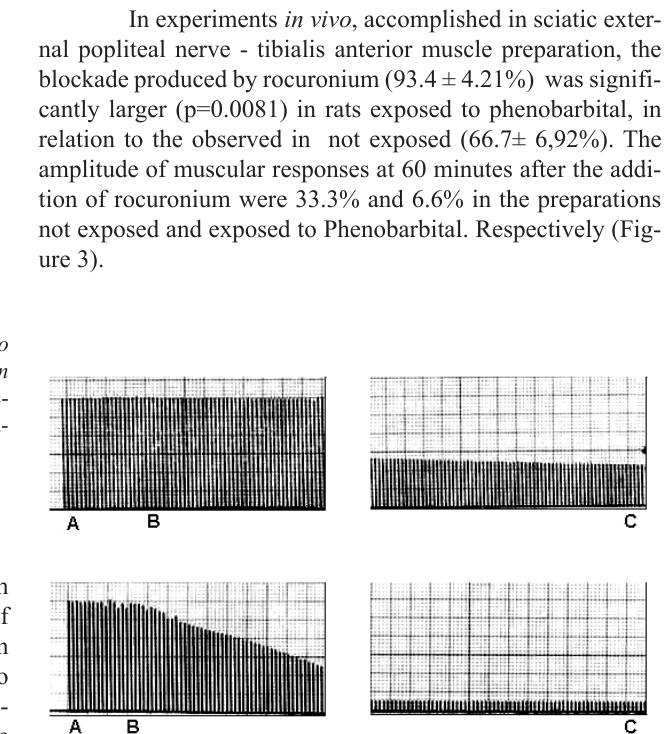
FIGURE 3 - Effect of rocuronium (0,6mg/kg) in muscular in vivo responses to indirect stimulation in sciatic nerve - tibialis anterior muscle preparation of rats not exposed (n=5) (upper tracing-neuromuscular blockade of 66.7%) and previously exposed (n=5) to phenobarbital - 20mg/kg (lower tracing-neuromuscular blockade of 93.4%). A = stimu- lation beginning; B = rocuronium addition; C = 60 minutes of stimula-